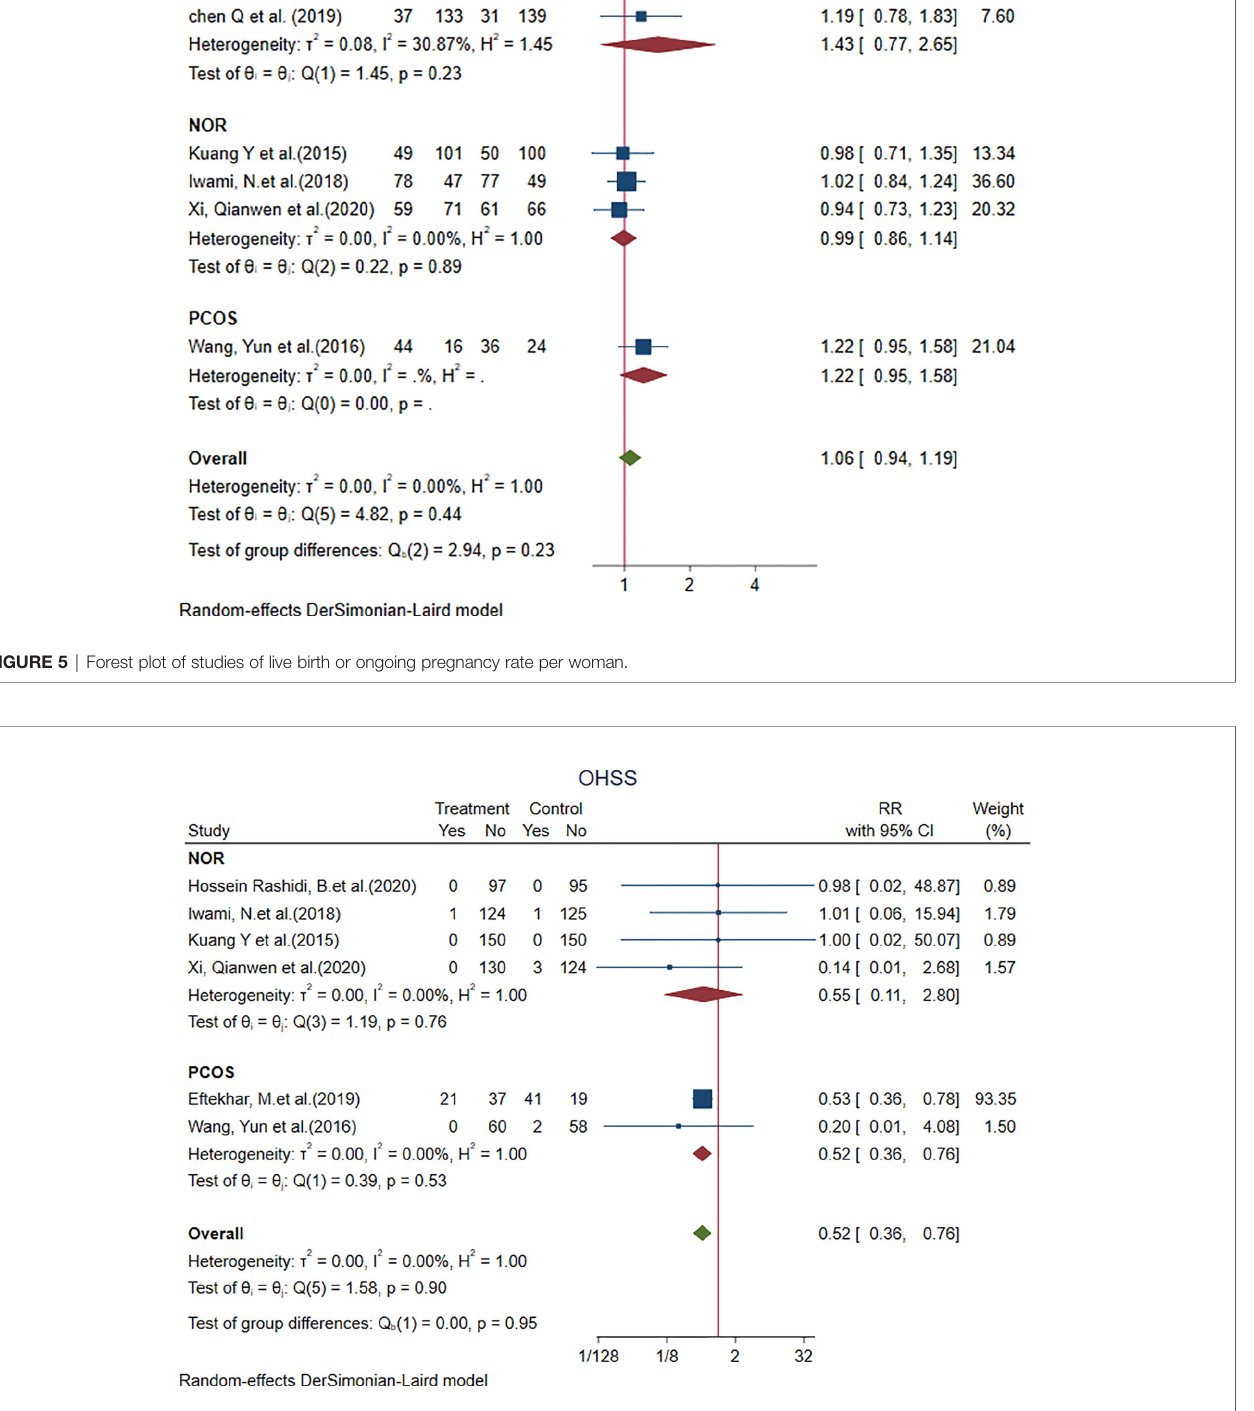
FIGURE 6 | Forest plot of studies of